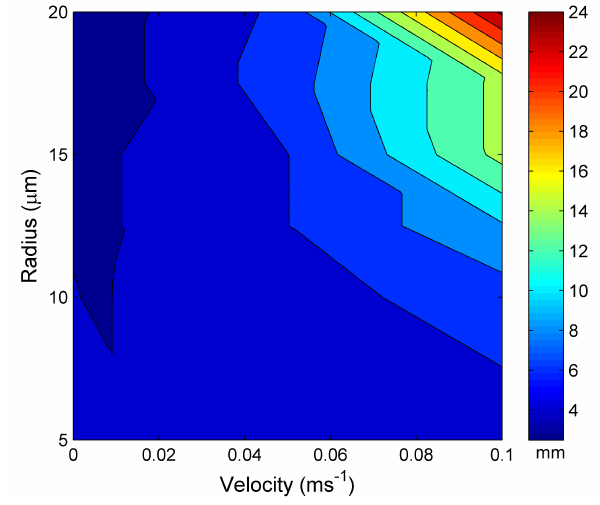
Figure 5. The distance taken to reach the steady-state length vs. the water hole radius and water input velocity at 30 ◦ C .